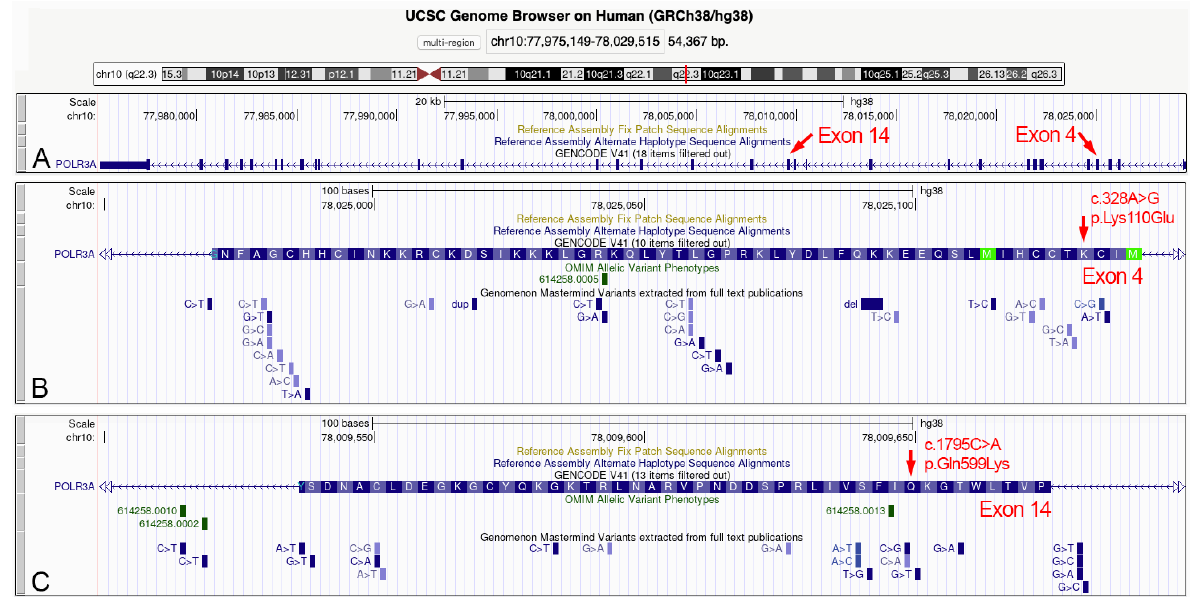
Figure 2. Localization of the two heterozygous mutations here described in the 5078-NP1688 patient. ( A ) Genomic organization of the POLR3A gene localized in the chromosomal band 10q22.3. Gene is transcribed form telomere to centromere side and consists of 31 exons. The exons 4 and 14 are highlighted and enlarged in the bottom panels. ( B ) Aminoacidic sequence codified by the exon 4 sequence. The 4th aminoacidic residue (lysine) corresponds to the mutated amino acid here identified for the first time. The currently described nucleotide mutations for the exon 4 sequence are shown at the bottom of panel B. ( C ) Aminoacidic sequence codified by the exon 14 sequence. The 9th aminoacidic residue (glutamine) corresponds to the mutated amino acid here observed in a POLR3-HLD patient, and previously described in the scientific literature. The currently described nucleotide mutations for the exon 14 sequence are shown at the bottom of panel C. Data and images from the UCSC Genome Browser (http://genome.ucsc.edu, accessed on 23 August 2022). The mutation in exon 4 is a novel missense mutation ((c.328A > G) (p.Lys110Glu)), that we show here for the first time, in a patient with a phenotype compatible with a